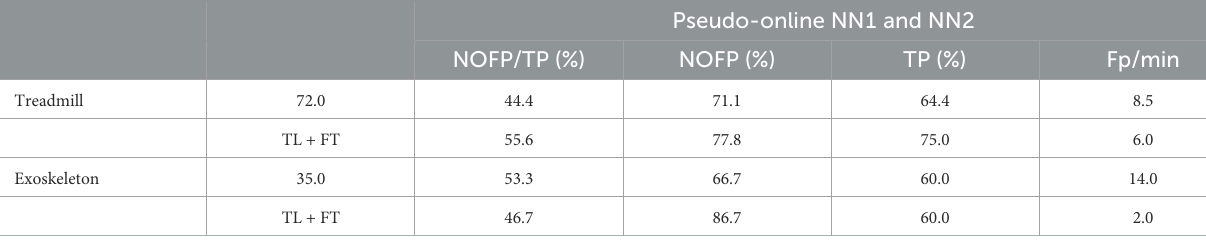
TABLE 9 Analysis transfer learning for treadmill and exoskeleton model in healthy subjects.